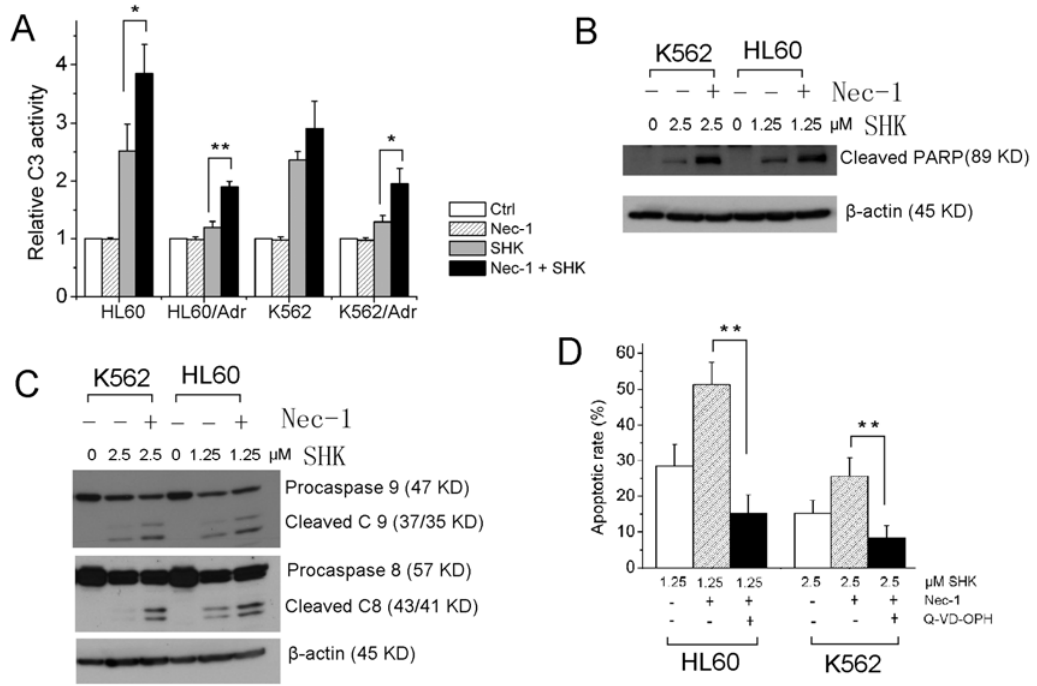
Figure 2. Nec-1 enhances shikonin-induced apoptosis through enhancing caspase activation in HL60 and K562 cells. ( A ) Cells were treated with shikonin in the presence or absence of Nec-1 for 12 h. Caspase-3 activation was measured using a Caspase-3/CPP32 Colorimetric Assay Kit; ( B ) HL60 and K562 cells were treated with shikonin in the absence or presence of Nec-1 for 12 h. The cleavage of PARP was detected by Western blot; ( C ) HL60 and K562 cells were treated with shikonin in the absence or presence of Nec-1 for 12 h. The activation of caspase 8 and 9 were reflected by the cleavage bands. β -actin served as an internal control; ( D ) HL60 and K562 cells were treated with 1.25 or 2.5 μ M shikonin for 12 h in the absence or presence of 60 μ M Nec-1 or 10 μ M Q-VD-OPH. Cells apoptotic rate was determined as described in Materials and Methods. Data are mean ± SD or representative of at least three independent experiments, and analyzed by Student’s t test. * p < 0.05, ** p < 0.01 compared with SHK treated